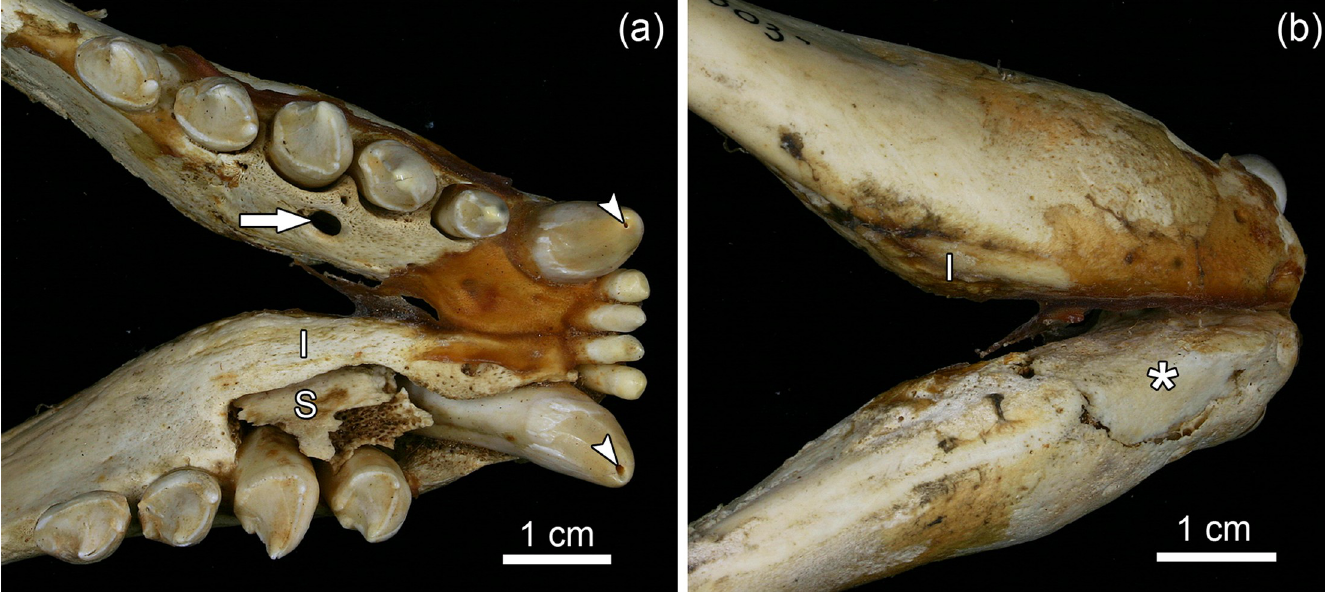
Fig 7. Dorsal (a) and ventral (b) views of the anterior portion of the mandibles of a juvenile Baltic grey seal ( Halichoerus grypus grypus ) from the 19th century (specimen ZMUC 303) showing signs of suppurative osteomyelitis. (a) Note opening of a draining tract in the left mandible (arrow), and presence of a large (entirely detached) sequestrum (S) and an involucrum (I) in the right mandible. Arrowheads: openings into the pulp cavities at the tips of both mandibular C. The right P 1 is missing, most likely due to intravital loss. (b) Note presence of a large sequestrum (asterisk), demarcated by a dividing line but still in place, in the left mandible, and occurrence of an involucrum (I) in the right mandible. An incomplete pathological fracture of the left mandible had occurred along the demarcation line.